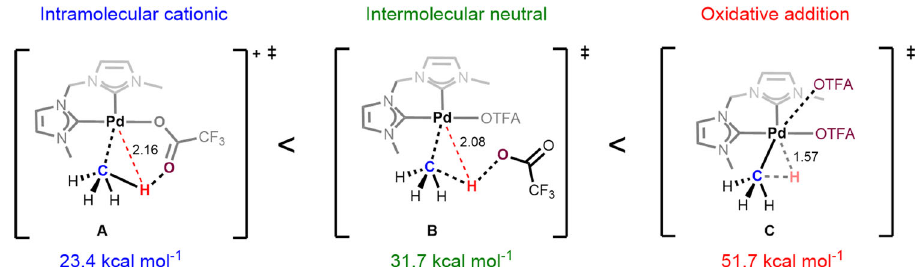
Fig. 4 Calculated transition states for the C-H activation of methane at Pd(II). All energies are relative to sigma complex 2.1 , Fig. 2. Pd-H red dashed lines in A and B do not represent an interaction, instead are representative of distance to the metal, whereas the dashed line in C does represent a